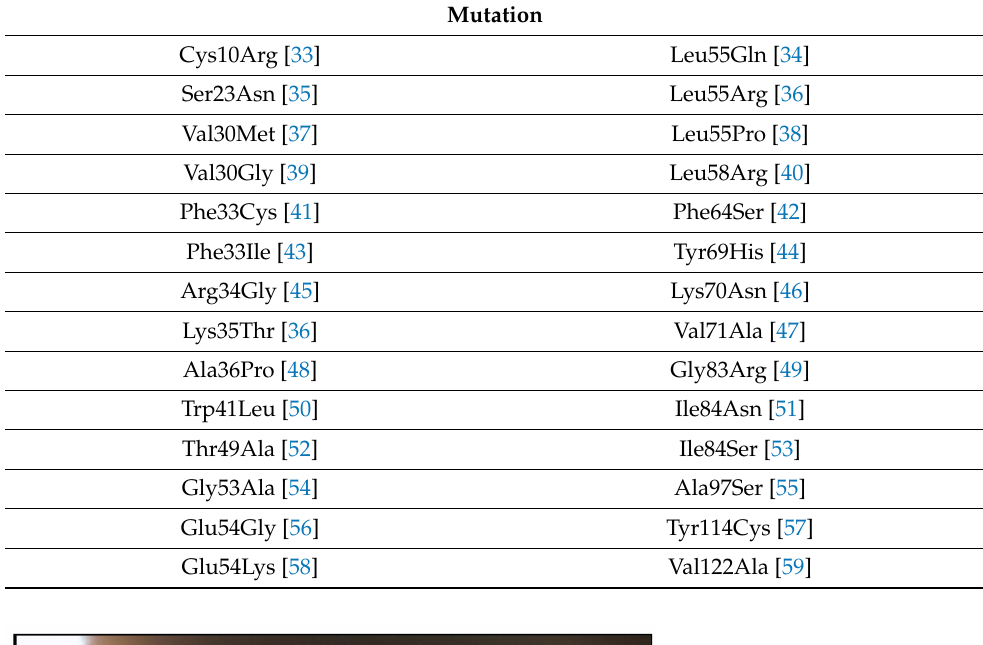
Table 2. Mutations associated with ocular involvement according to www.amyloidosismutations. com [32].